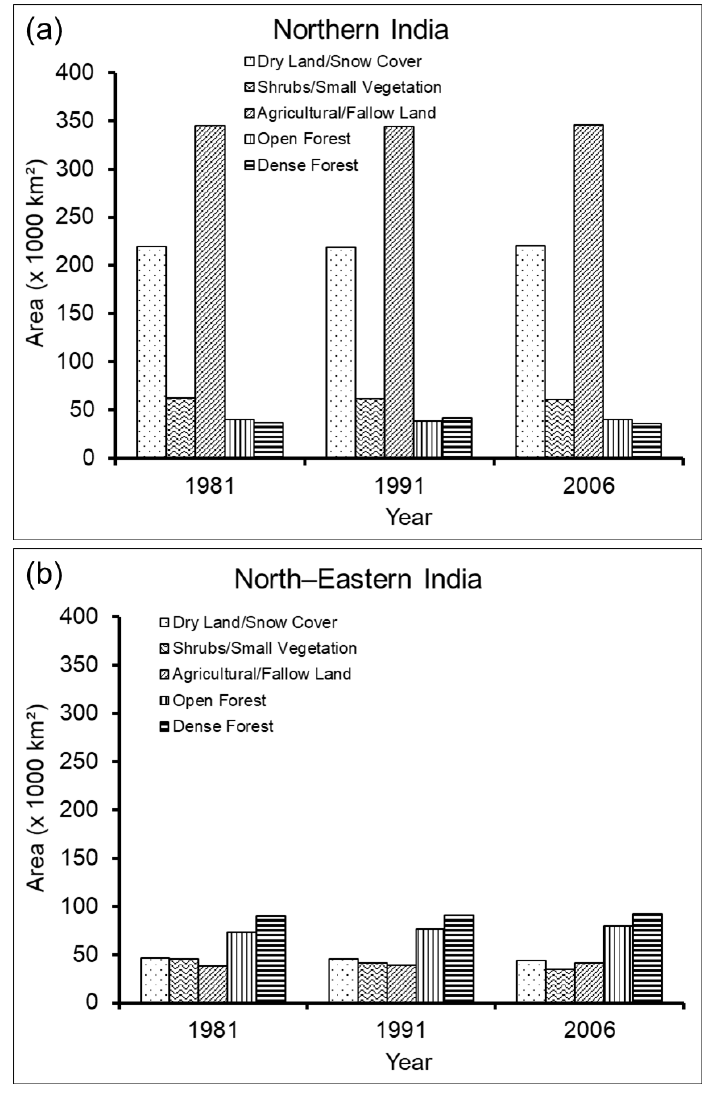
Figure 5. Areas under each LULC type over ( a ) NI and ( b ) NEI. Table 3. Area estimation under each LULC types; ( a ) Northern India, ( b ) North-Eastern